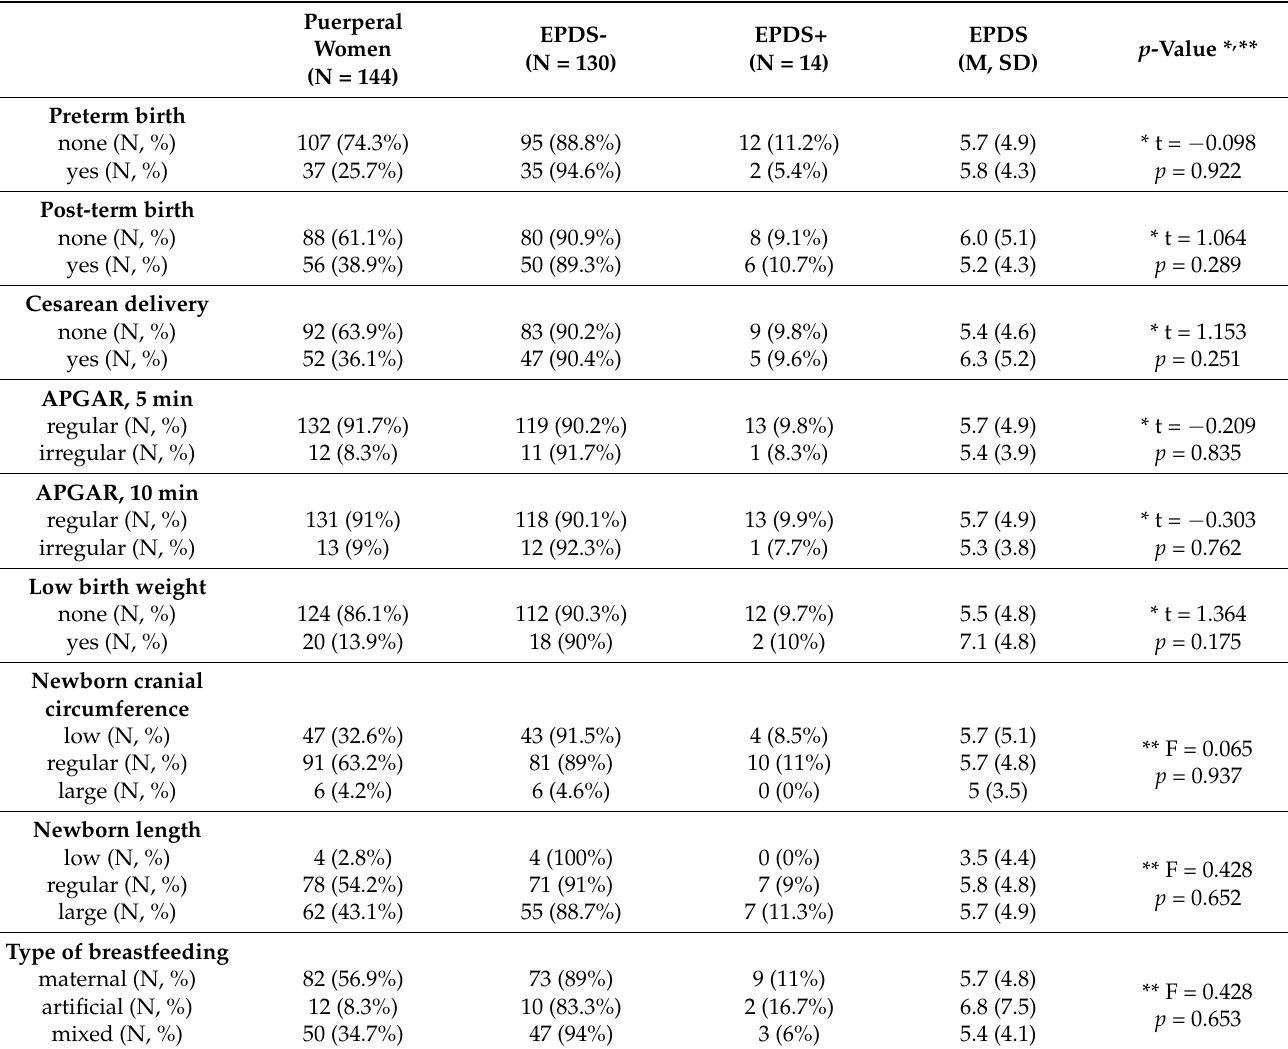
Table 4. Delivery-related characteristics of the postpartum